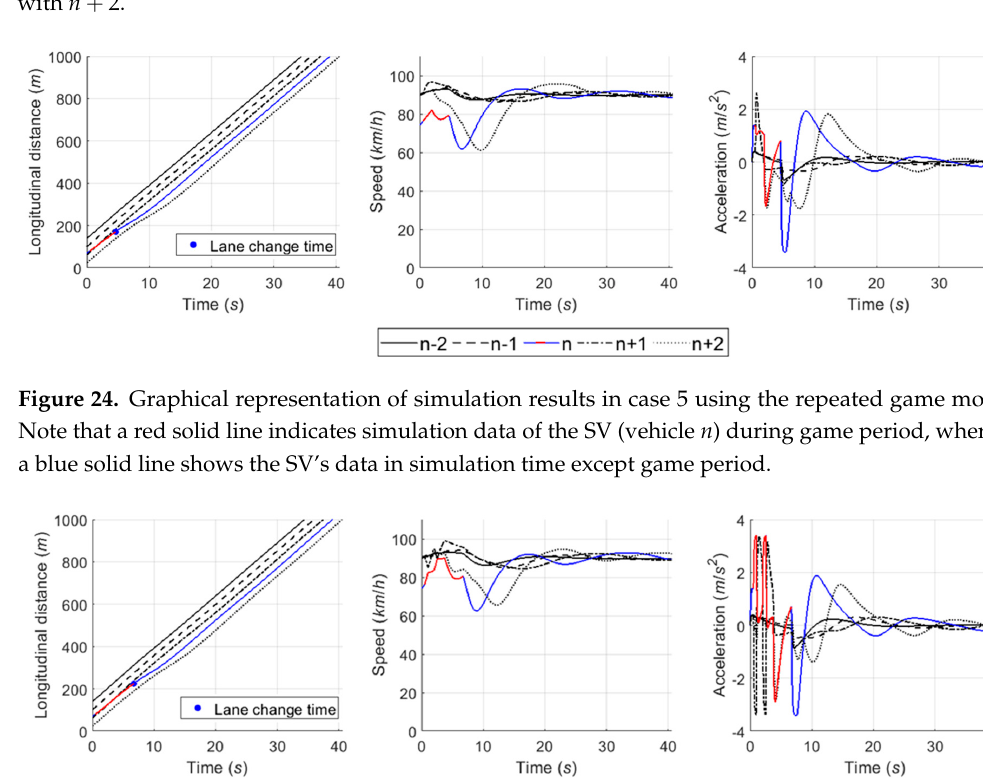
with (cid:1866) + 2 .